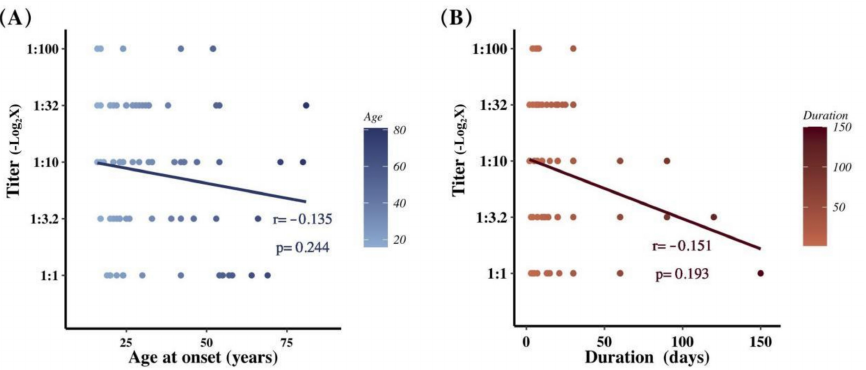
Figure 1. The distribution scatter plots of antibody titers by age of onset ( A ) and disease duration ( B ). The vertical axis shows the antibody titers after negative-logarithmic transformation, and the horizontal axis shows the time lapse.